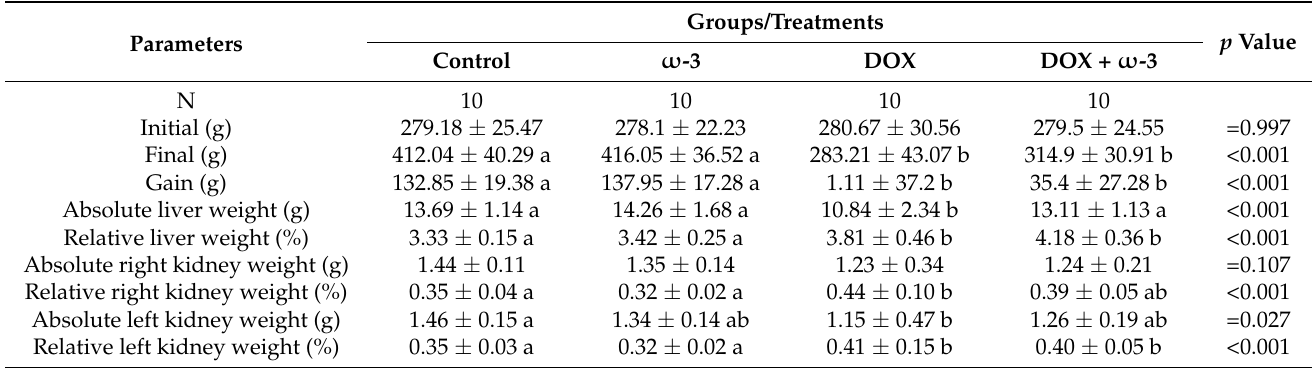
Table 1. Effects of omega 3 ( ω -3) supplementation on doxorubicin (DOX)-induced effects on body weight parameters and liver and kidney weights (absolute and relative).